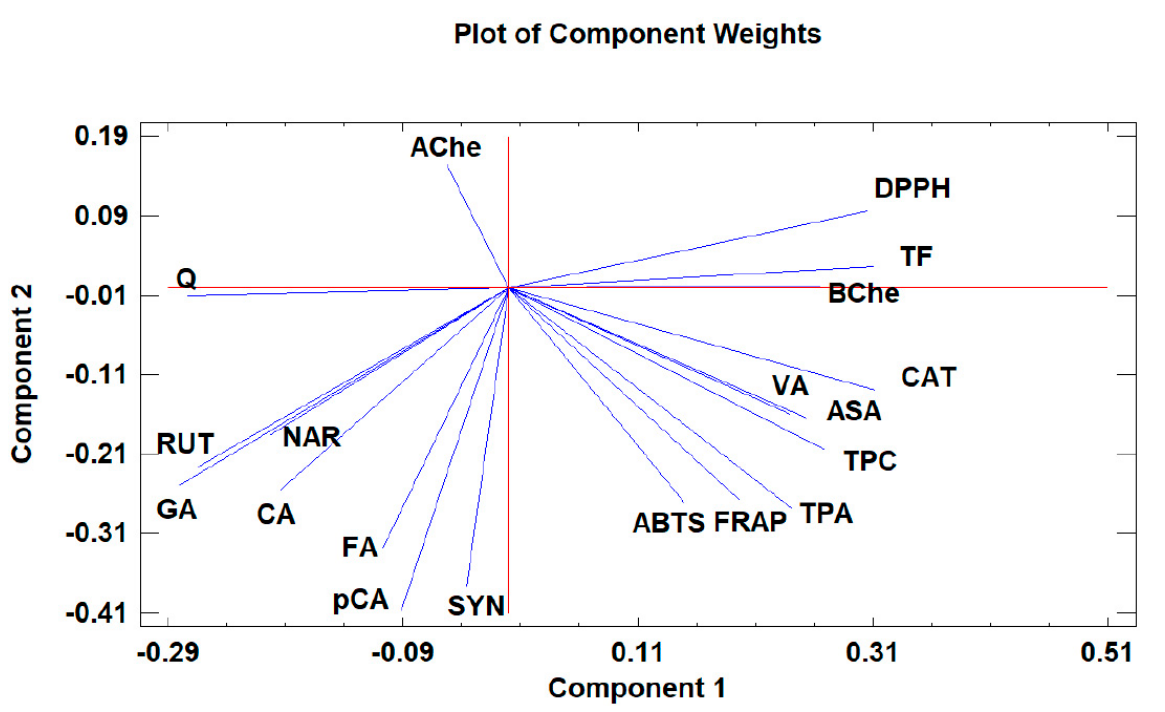
Figure 2. The loading plot of principal components 1 and 2 for the tested Withania somnifera samples extracted with two different protocols (hydromethanolic and aqueous extracts) .